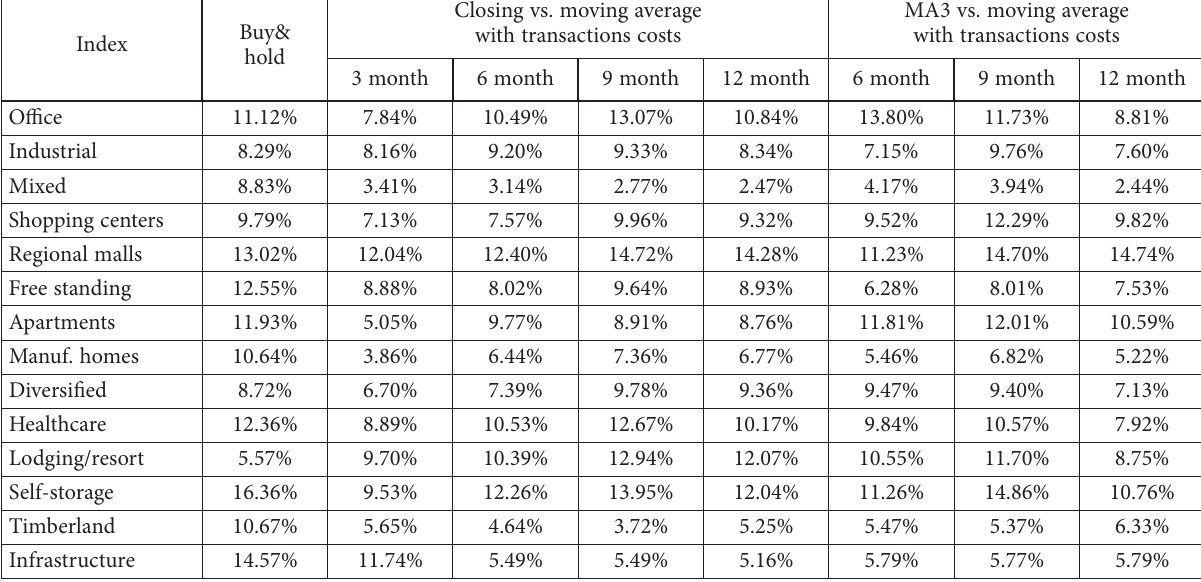
Table 4. Annual returns from Buy-and-hold strategy compared to technical trading strategy based on moving averages (MA) Closing vs. moving average Buy& with transactions Index hold